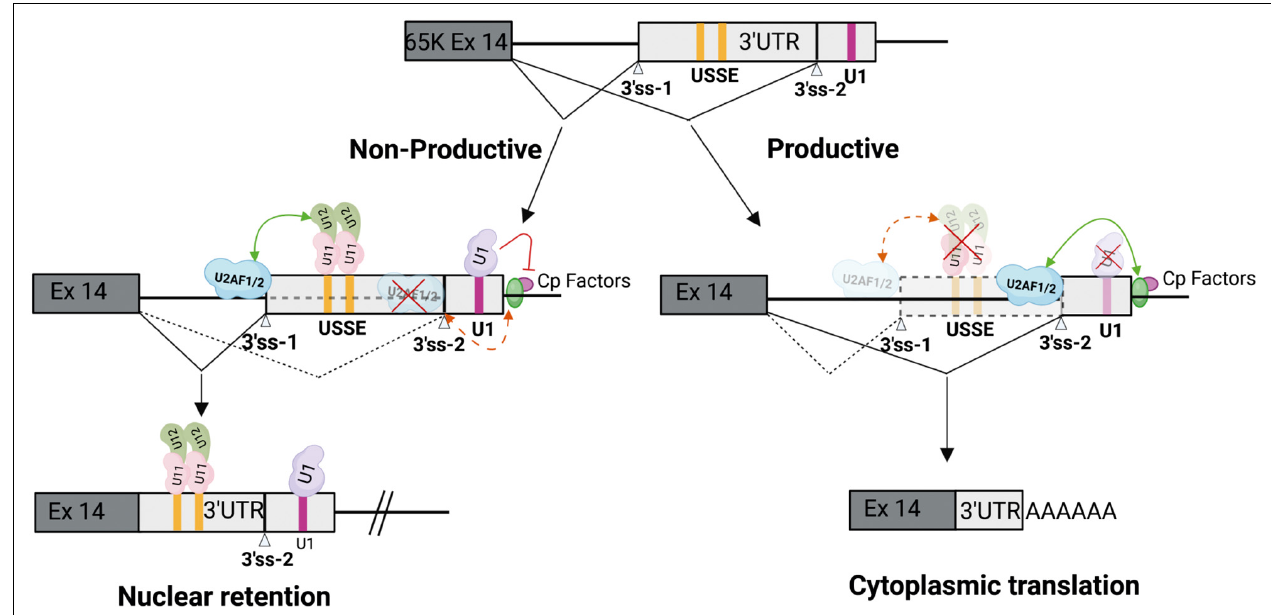
FIGURE 2 | Cooperation between minor and major spliceosomes. Feedback regulation in the minor RNPC3 (65K) gene is mediated by protein-protein interactions between the U11/U12 di-snRNP bound to the USSE and upstream U2AF1/2 to enhance recognition of an upstream 3 (cid:48) ss. Cp factors denote cleavage and polyadenylation factors. This leads to formation of either productive mRNA translated in the cytoplasm, or unproductive mRNA that is retained in the nucleus. Modified from Verbeeren et al. (2017). Created by